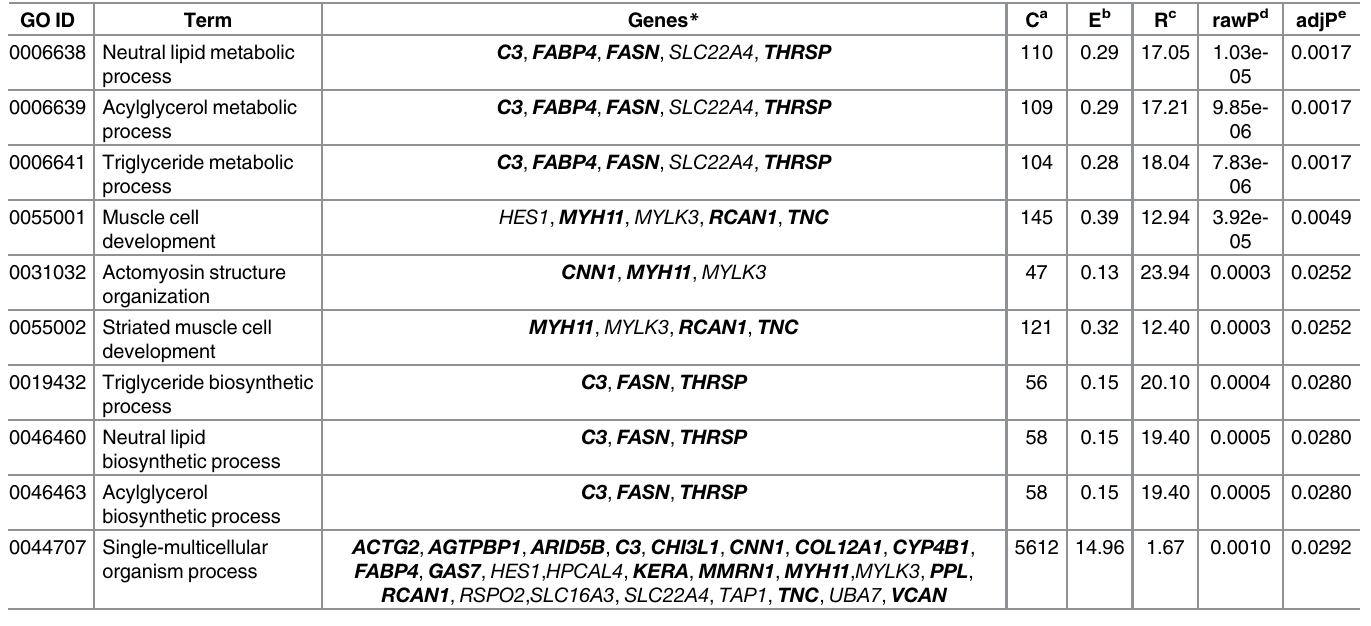
Table 4. Biological processes significantly enriched by WebGestalt for the differentially expressed genes in the Longissimus dorsi muscle, com- paring high and low genomic breeding value groups for iron content in Nelore